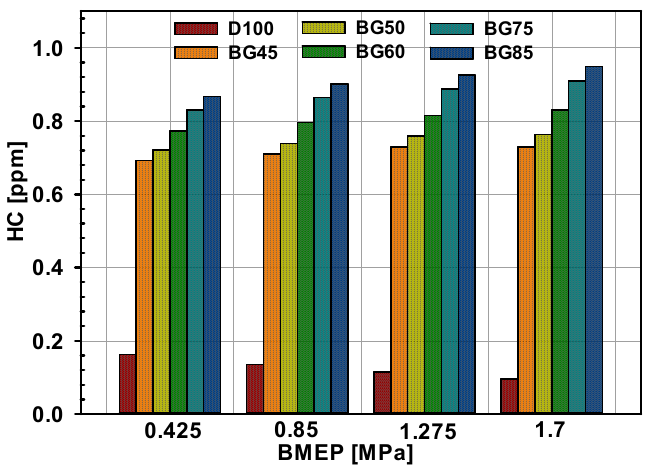
Figure 13. Variations of HC emissions with engine load.